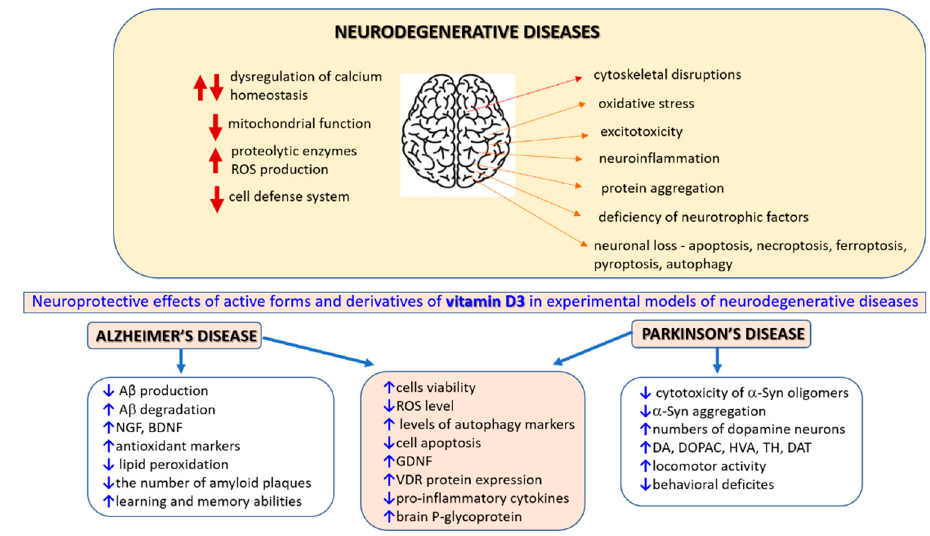
Figure 2. The pathogenic mechanisms of neurodegenerative diseases and neuroprotective effects of different forms of vitamin D3 in experimental models of Alzheimer’s and Parkinson’s diseases.